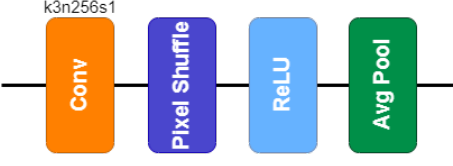
Figure 4. Upsampling layer